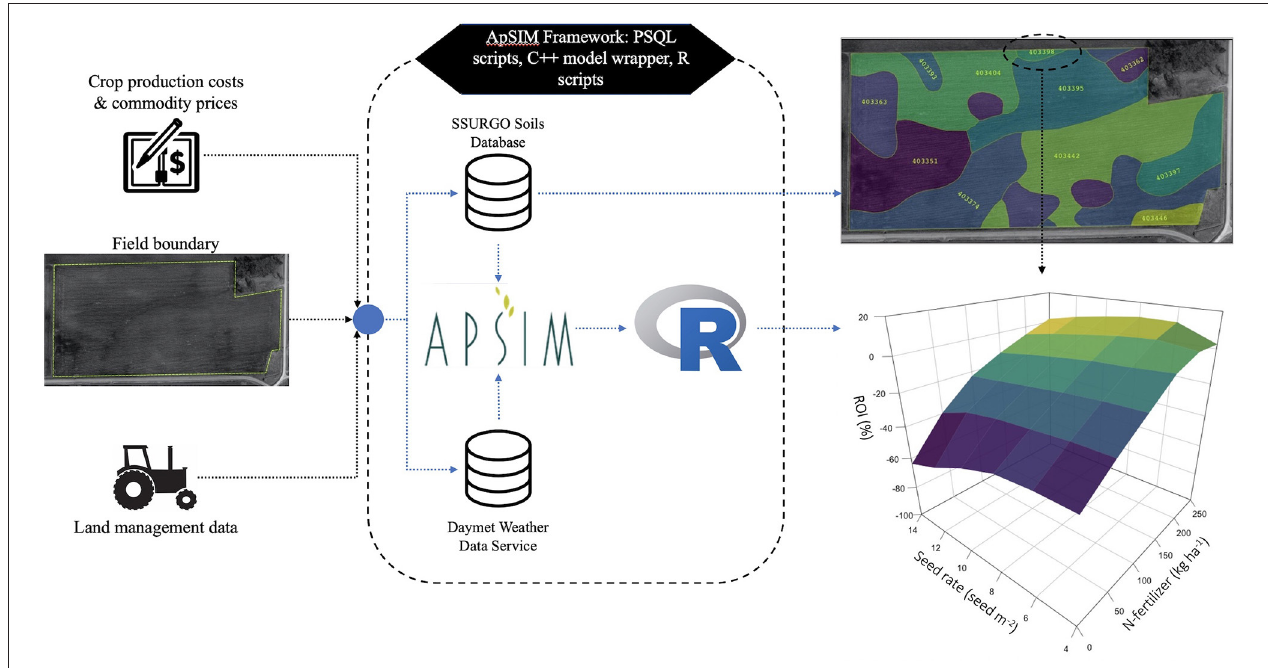
FIGURE 1 | Data flow through the model framework, which automates the parameterization of the APSIM model for all SSURGO soils within a specified cropping system field boundary and estimates economic and environmental responses to varying management combinations for each soil.